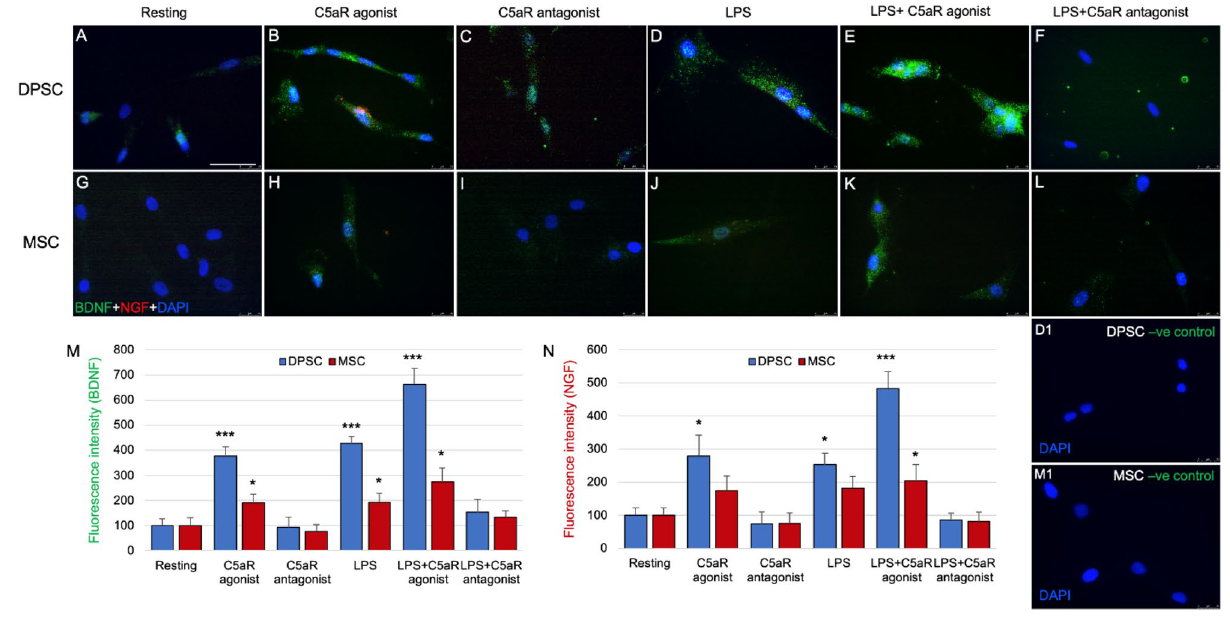
Figure 4. C5aR or LPS-stimulated DPSCs express more BDNF than BM-MSCs. ( A – L ) Magnified pictures from the respective boxes of Figs. 2 and 3 in subsequent order. Groups: Resting ( A , G ), C5aR agonist ( B , H ), C5aR antagonist ( C , I ), LPS ( D , J ), LPS + C5aR agonist ( E , K ), LPS + C5aR antagonist ( F , L ). Double fluorescence immunohistochemistry with anti-BDNF (green) and anti-NGF (red) deposit’s reaction product in punctae of both stem cells. BDNF and NGF immune intensities are significantly higher in the C5aR agonist or LPS + C5aR- agonist treatment group ( B , E & H , K ) compared to resting ( A , G ) and C5aR antagonist treatment ( C , I ) groups. ( M , N ) Bar graphs showing the fluorescence intensity of BDNF and NGF in various treatment groups normalized to untreated control of resting cells. C5aR stimulation by C5aR-agonist or co-stimulation with LPS specifically increases BDNF and NGF (E) expression in DPSCs undergoing differentiation. (D1) DPSCs negative control. (M1) BM-MSCs negative control. Values for resting control were set at 100 as a reference. * p < 0.05,